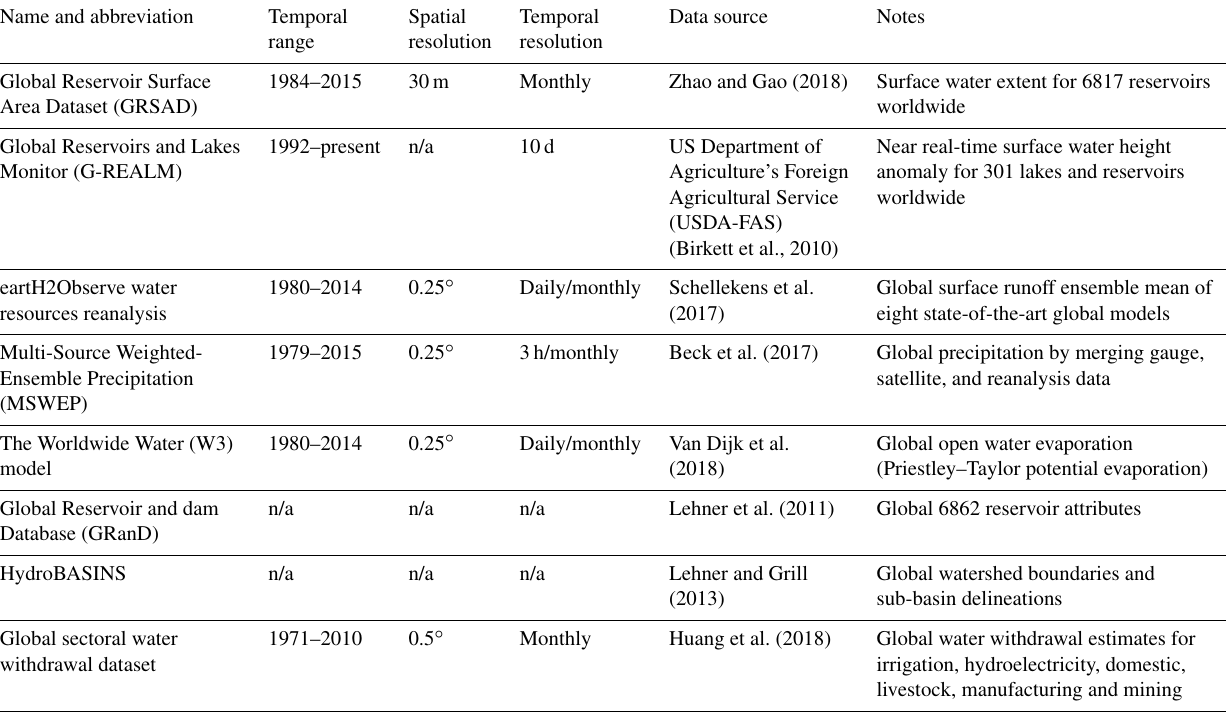
Table 1. List of the spatial data used in the analyses with source, resolution, and temporal coverage of data.